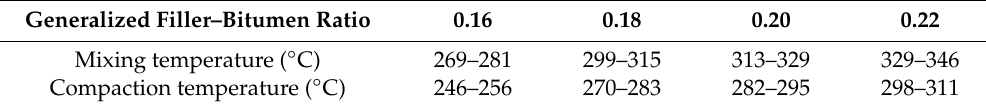
Table 9. Construction temperatures of the CRMB mixture.